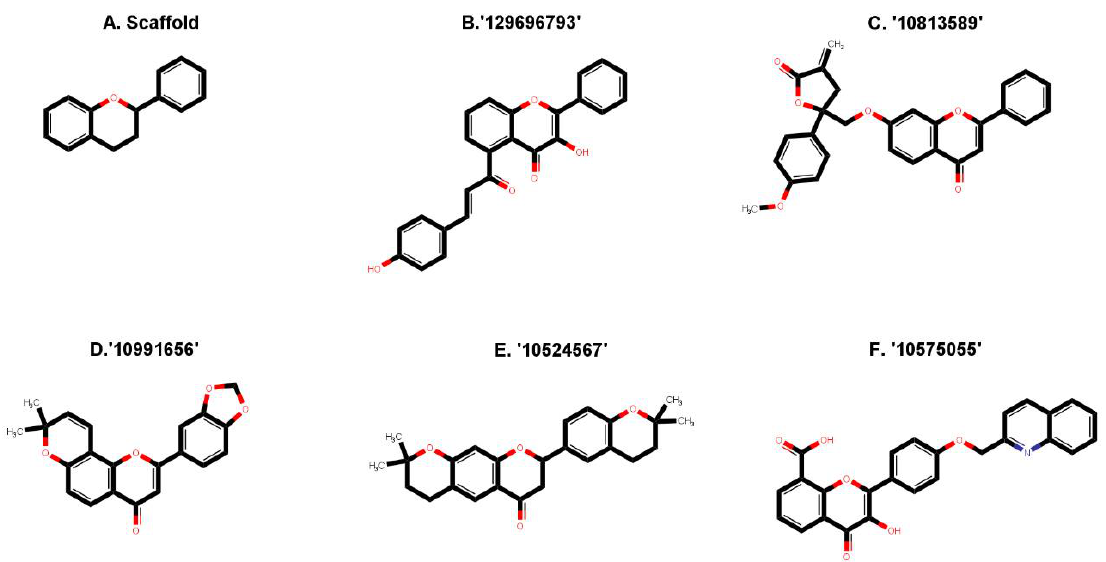
Figure 2. Two-dimensional sketch of flavonoid scaffold ( A ) and top selected flavonoids for MEK1 ( B – F ). The flavonoids are represented by their PubChem CID. Heteroatoms oxygen (O), and nitrogen ( N )with their balancing hydrogens are shown as red, blue, and green, respectively.